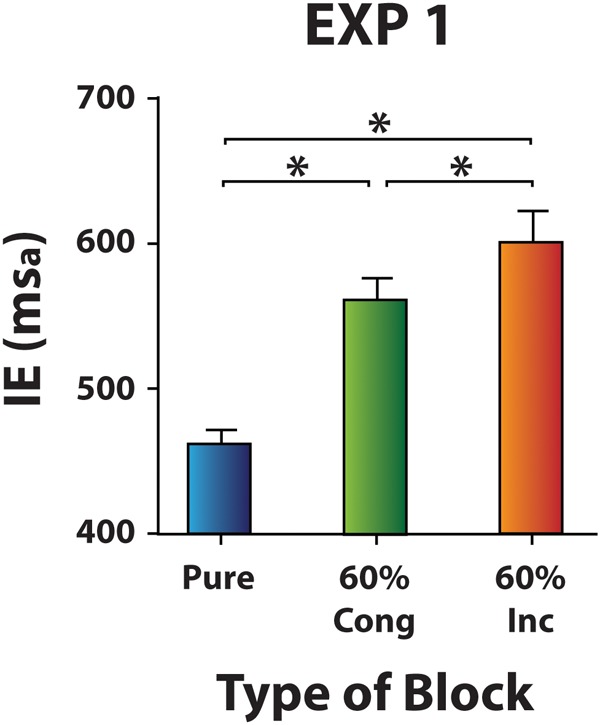
Distractor-absent trials in Pure and Mixed blocks (Experiment 1). Mean IE scores for distraction-absent trials in different blocks. Error bars represent the standard error of the mean. Asterisks mark significantly different mean/s.